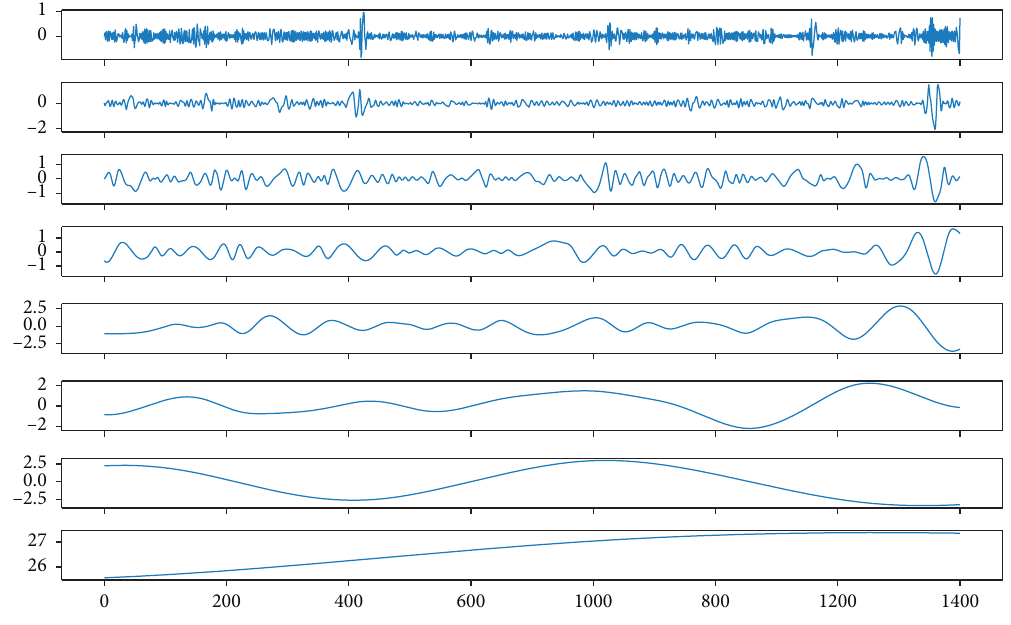
Figure 13: The EMD decomposition graphs of DAX time series.